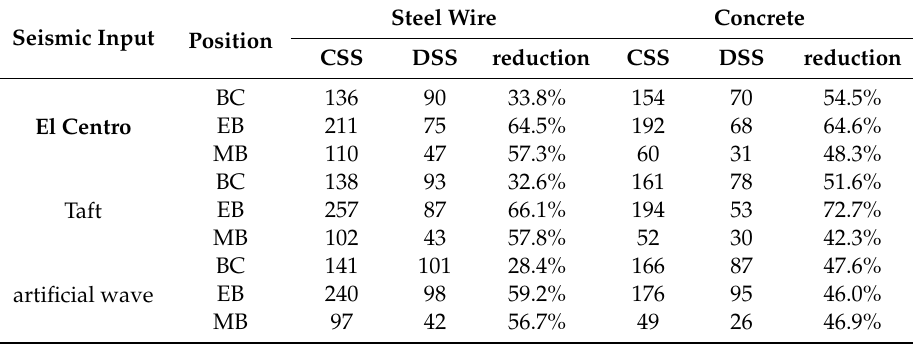
Table 8. Maximum strain response of key parts ( µε